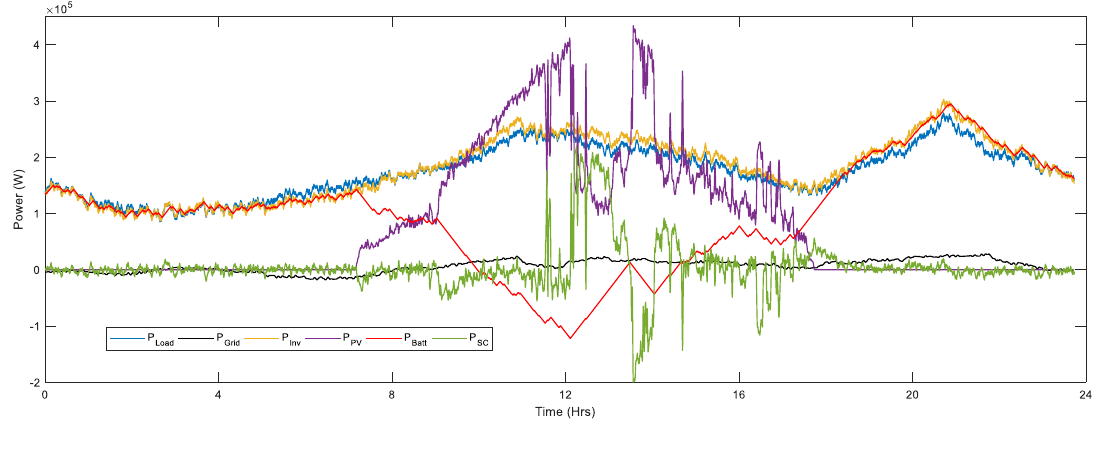
Figure 10. Power exchange and sharing among energy sources.